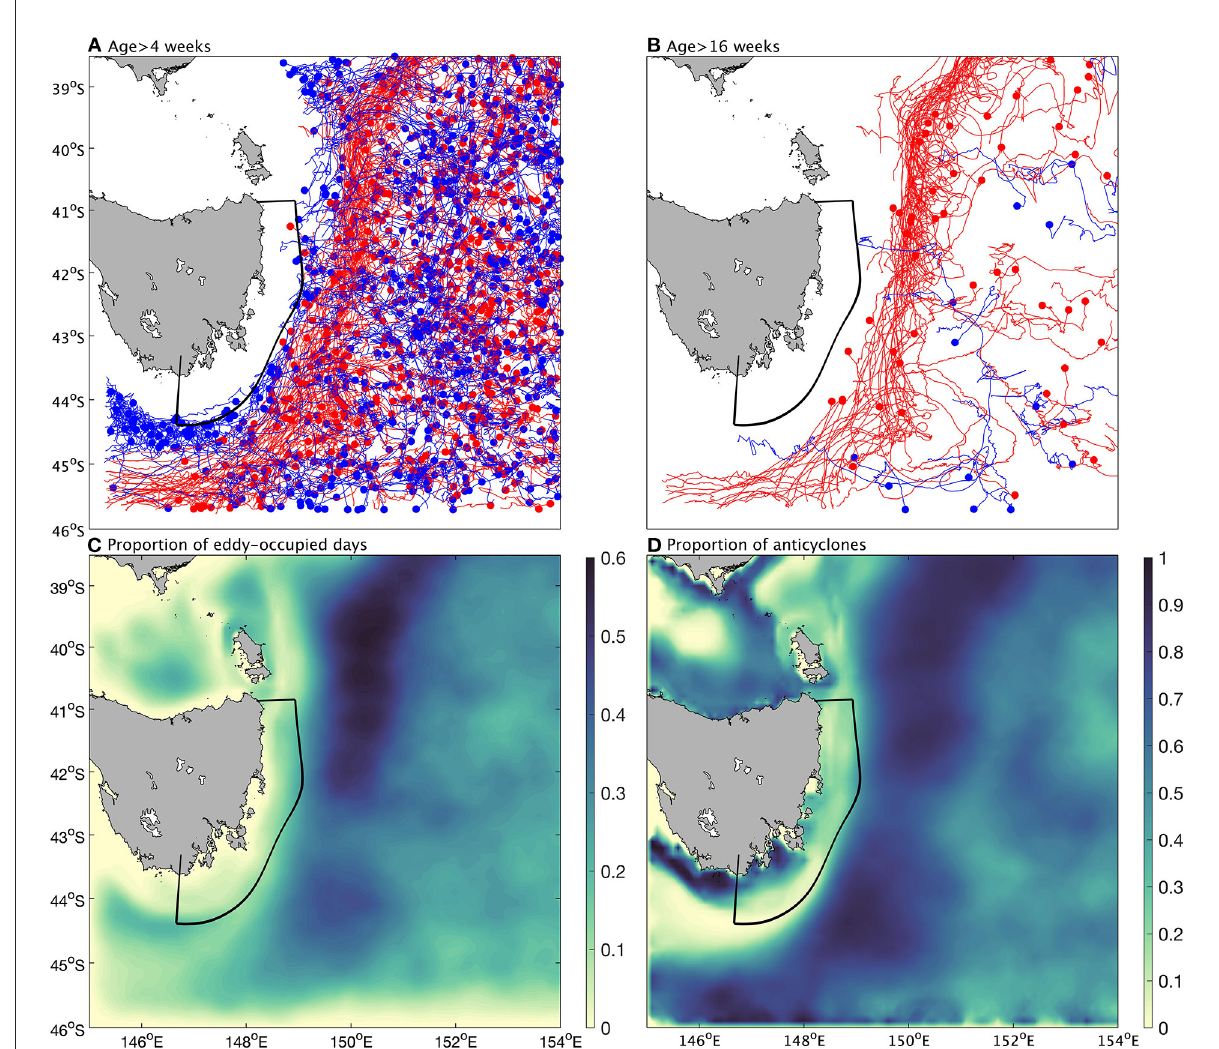
FIGURE2 Eddy field in the southern Tasman Sea based on BRAN3 data from 1994 to 2016. Detected eddy tracks are shown with lifetimes (A) > 4 weeks, and (B) > 16 weeks. In (A,B) the red (blue) dot stands for the end point of an anticyclonic (cyclonic) eddy and the line indicates the track of this eddy. (C) Proportion of eddy-occupied days during 1994 to 2016 in the southern Tasman Sea. (D) Proportion of anticyclonic eddies in all tracked